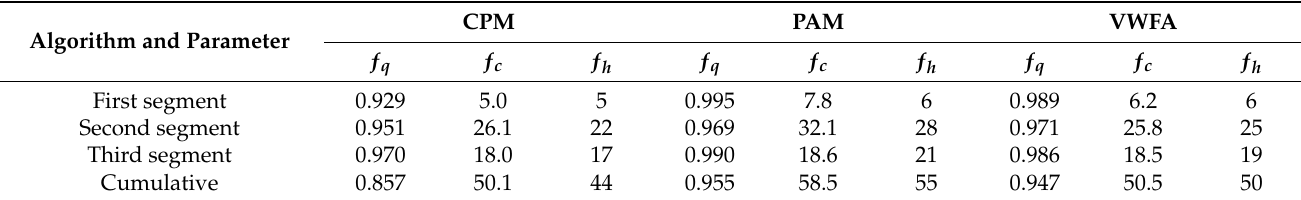
Table 7. Scheduling results of different algorithms. Algorithm and